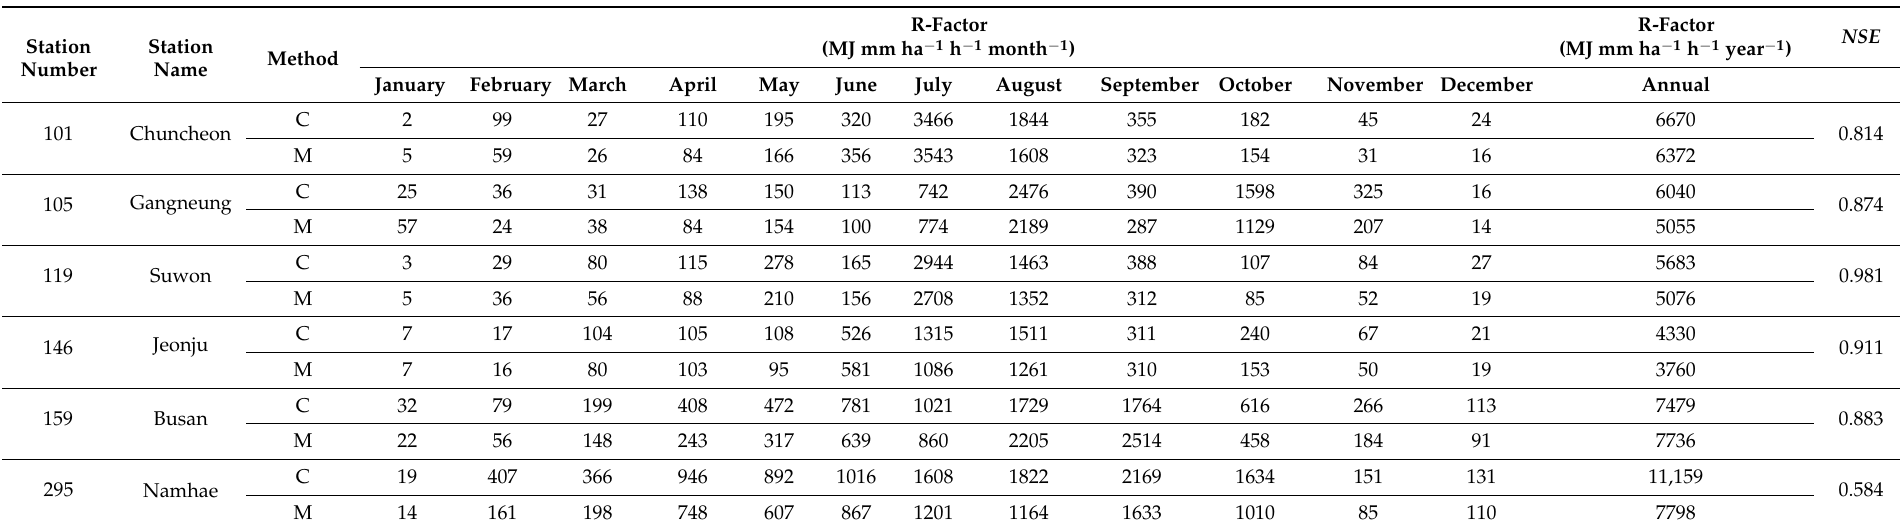
Table 7. Monthly R-factor calculated (C) by the previous method and predicted (M) by Deep Neural